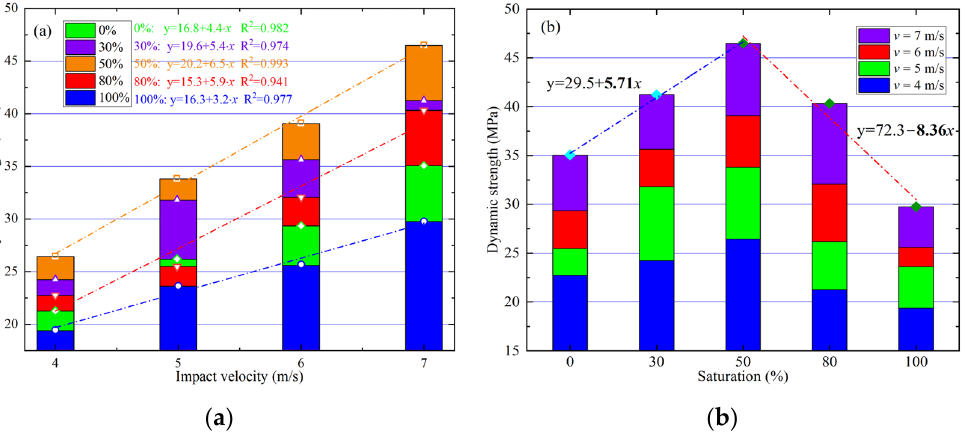
Figure 10. Dynamic peak strength versus impact velocity ( a ) and saturation ( b ) of the sample.